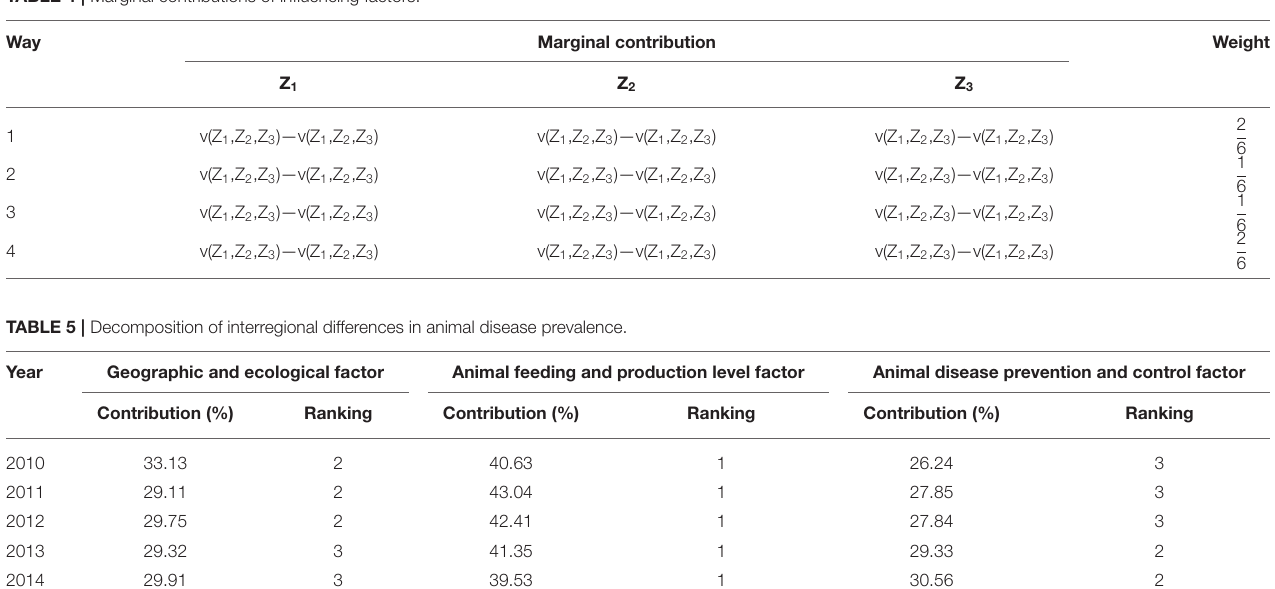
TABLE 4 | Marginal contributions of influencing factors.